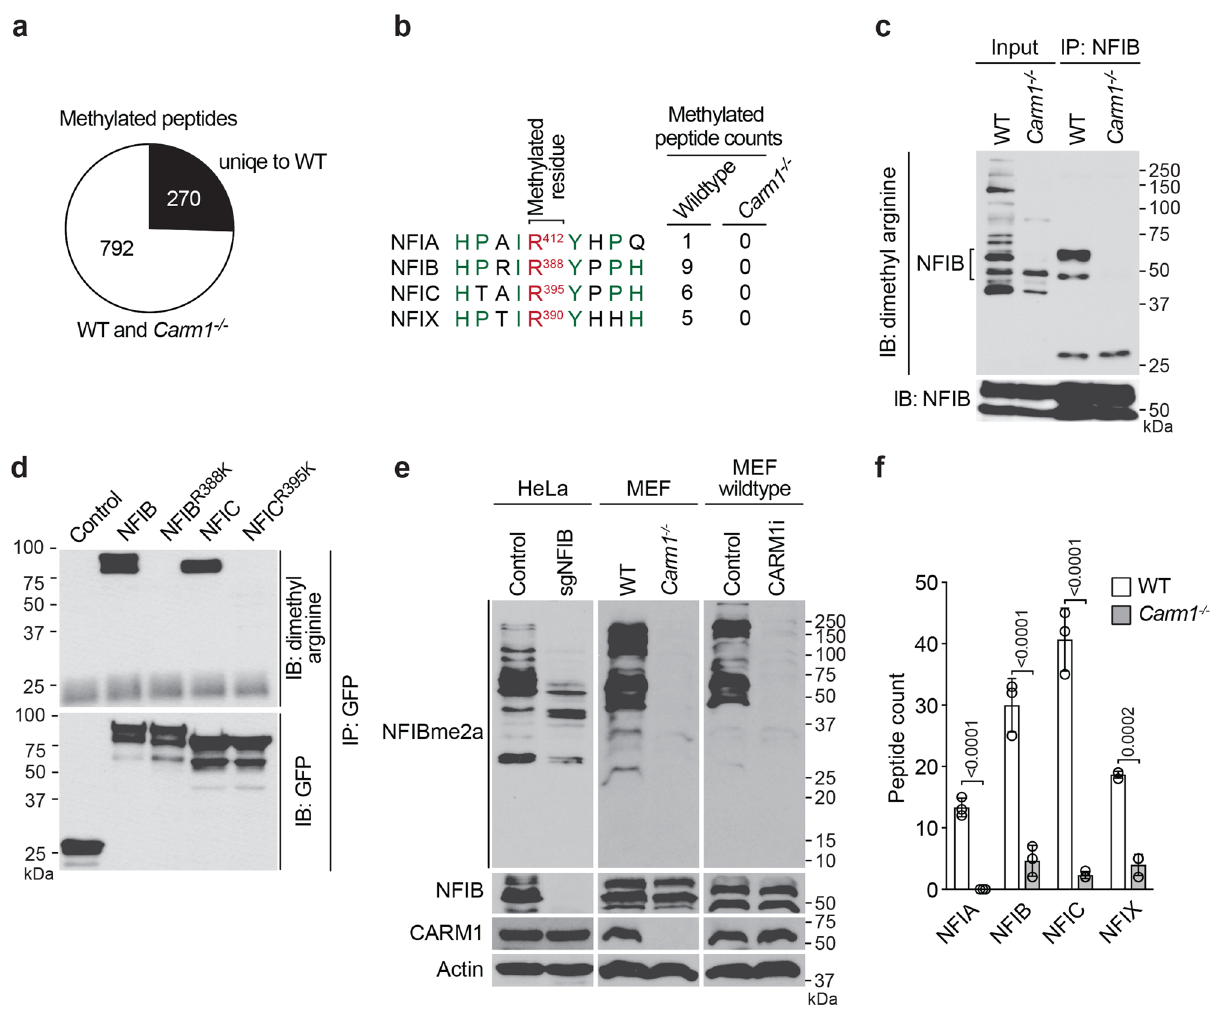
Fig. 1| Identi fi cationofNFIBasaCARM1 substrate.a ADMA-containing proteins were immunoprecipitated from CARM1 wild-type (WT) or knockout ( Carm1 − / − ) MEFs, and identi fi ed by LC-MS/MS. b Identi fi ed peptides from the nuclear factor I family. c NFIBproteinwasimmunoprecipitatedfromeitherCARM1WTorKOMEFs, and immunoblotted with antibodies against ADMA (D4H5) or NFIB. d GFP vector control, GFP-NFIB-WT or -R388K, GFP-NFIC-WT or -R395K constructs were trans- fected into HeLa cells. GFP-tagged proteins were immunoprecipitated and